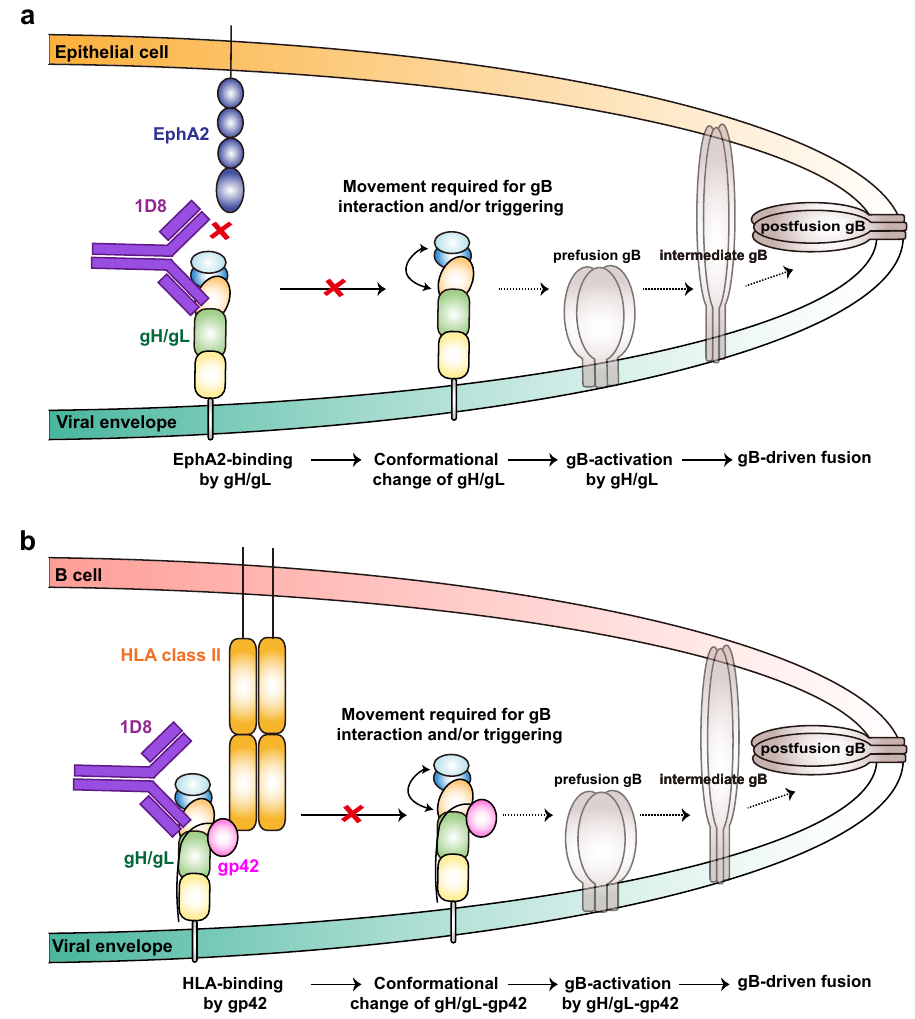
Fig. 6 Possible mechanisms of 1D8-mediated neutralization. a For epithelial cells, 1D8 could interfere the interaction between gH/gL and EphA2 either by directly restricting access to the interface or by indirectly posing allosteric hindrance. It could also restrict the movement across the D-I/D-II groove of